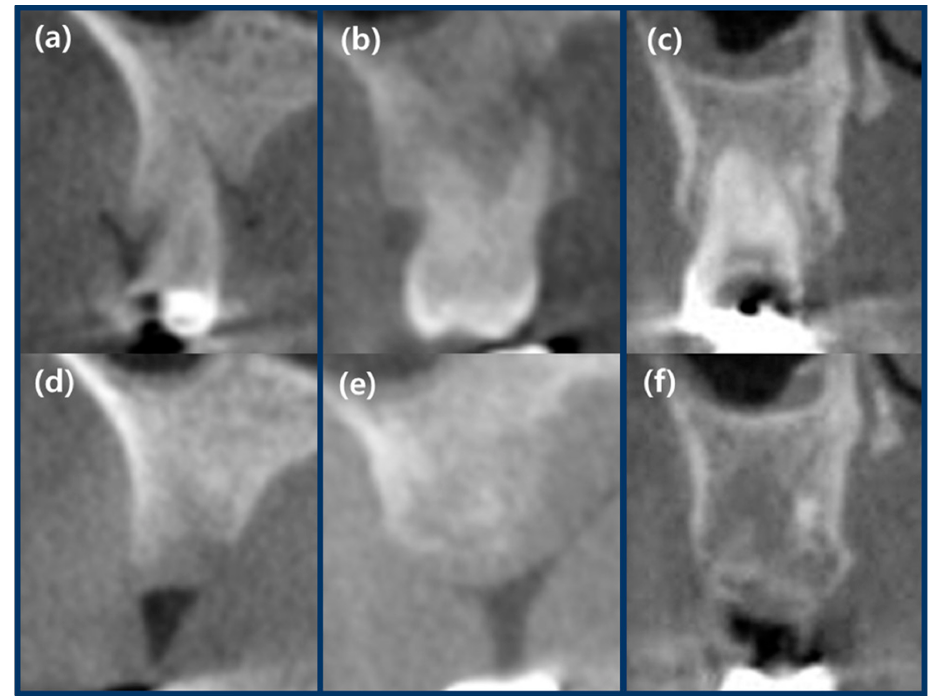
Figure 6. Cross-sectional images of the baseline and 4 months after ridge preservation. ( a – c ) Preoperative CBCT images of Groups A, B, and C, respectively. ( d – f ) Four months after extraction and ridge preservation for the Bio-Oss collagen, demineralized dentin matrix (DDM), and recombinant human bone morphogenetic protein-2 (rhBMP-2)/DDM groups. The buccal bone height (BBH), lingual bone height (LBH) and horizontal ridge width at 1, 3, and 5 mm from the alveolar crest (RW-1, RW-3, RW-5) were measured from the reference lines shown in Figure 5.